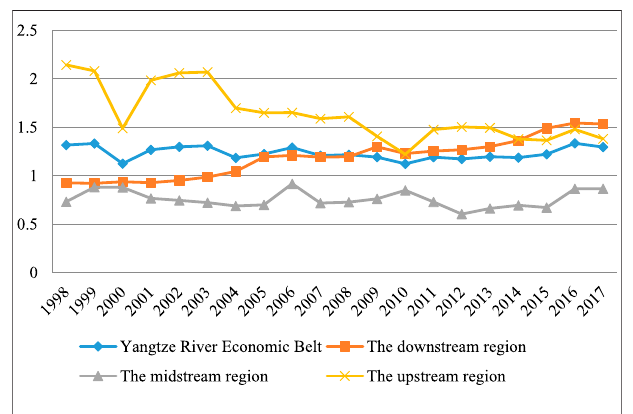
FIGURE 4 | Variation trend of mean value of pure technical ef fi ciency (1998 – 2017).